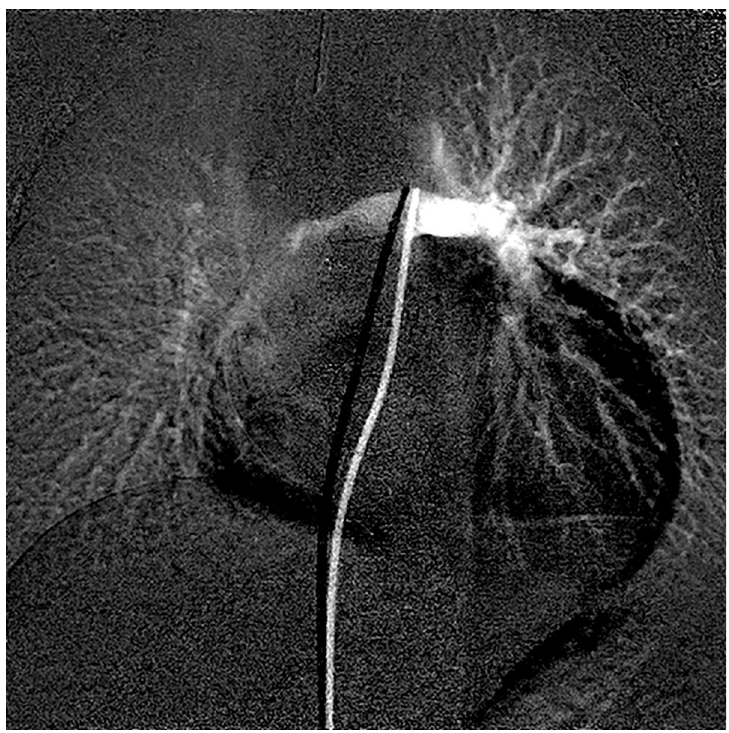
Fig 6. Unilateral distribution of contrast agent injected into the main pulmonary trunk in the first cardiac cycle after injection. Even if contrast agent is injected into the main pulmonary trunk, it is unilaterally distributed mainly to the left pulmonary artery during the first cardiac cycle after injection. Therefore, accurate measurement of the right-to- left pulmonary blood flow ratio with our model should be performed over 50–90% of the R-R interval during the retention